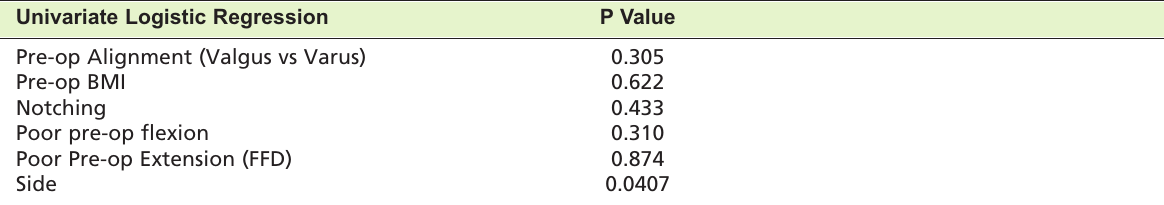
Subgroup analysis between early and late Table III: